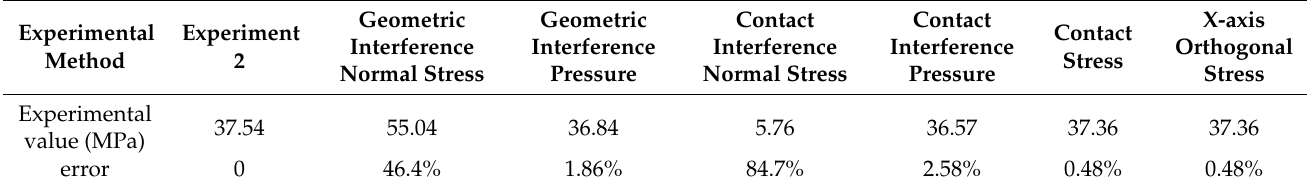
Table 11. Experiment 2 and simulation value